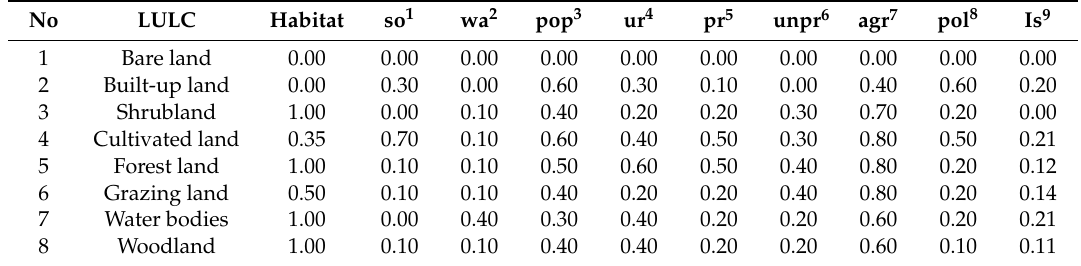
Table 6. Land use / cover types and their sensitivity to the